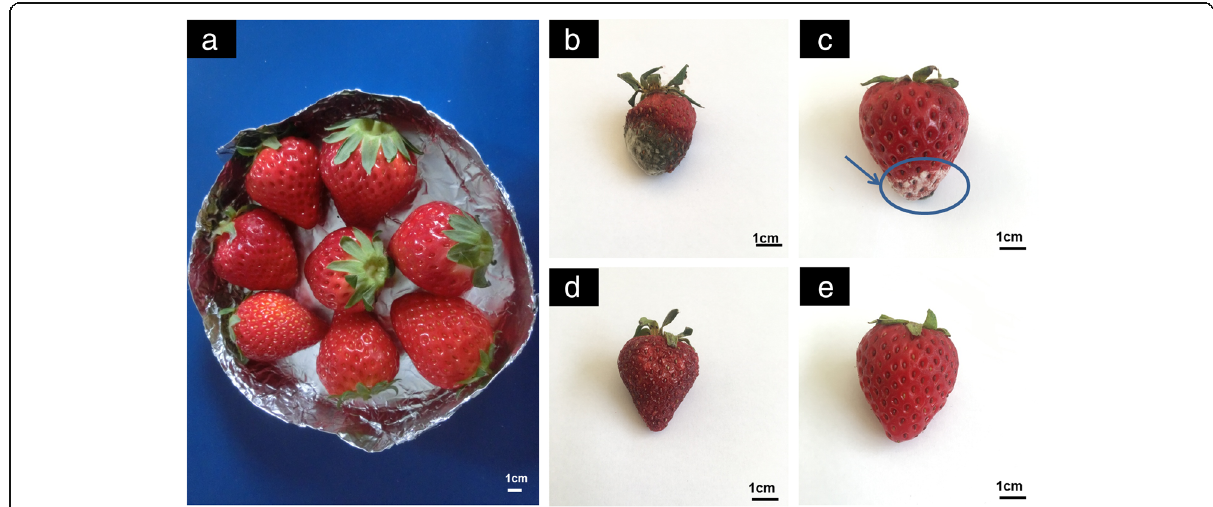
Fig. 8 The initial strawberries a and the effects of different treatments on appearance of strawberries of the same size after 6 days of storage at ambient temperature: b blank control, c protected with plastic film, d protected by CMCS/PEO paint coatings, and e protected with electrospun CMCS/PEO nanofiber